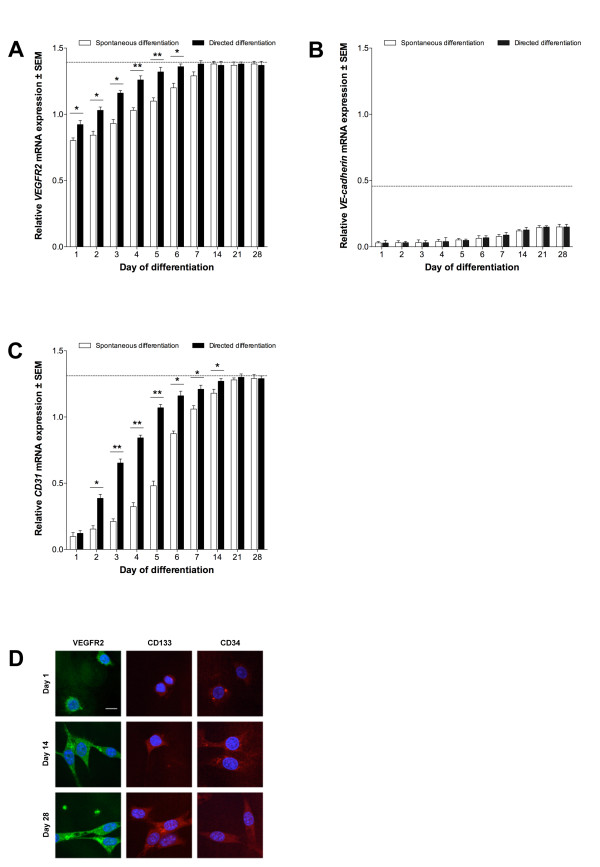
Endothelial differentiation of stem cells. (A) VEGFR2, (B) VE-cadherin and (C) CD31 expression in ESCs, relative to 60% confluent ECs (± SEM; n = 3). Dotted line indicates expression in 60% confluent EPCs. Directed differentiation with ECCM, significant differences between treatments indicated (*P < 0.05, **P < 0.01). (D): VEGFR2, CD133 and CD34 proteins in ECCM-treated ESCs. Scale bars = 10 μm.